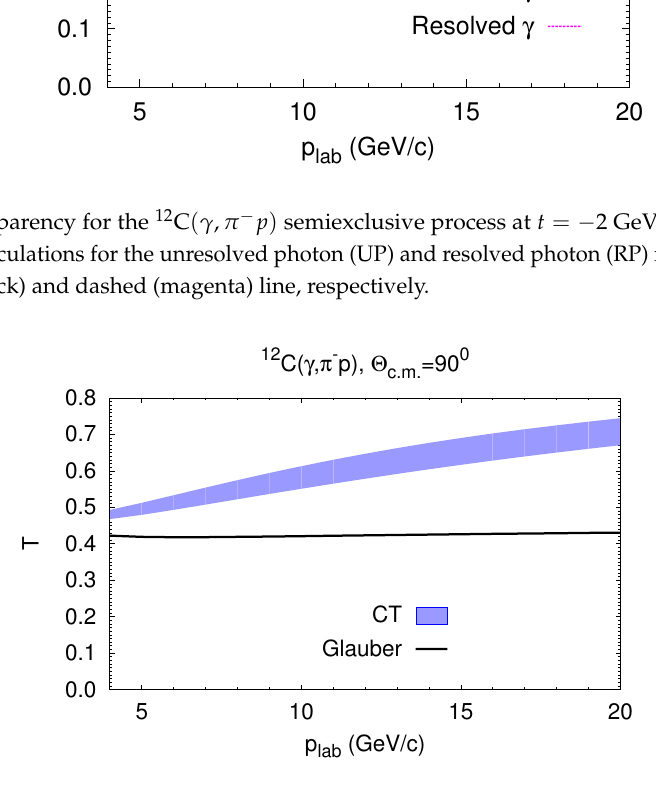
Figure 4. Transparency for the 12 C ( γ , π − p ) semiexclusive process at Θ c . m . = 90 ◦ vs. photon beam momentum. The band and solid line correspond to the QDM and Glauber model calculations, respectively. The upper (lower) boundary of the band is given by ∆ M 2 = 0.7 (1.1) GeV 2